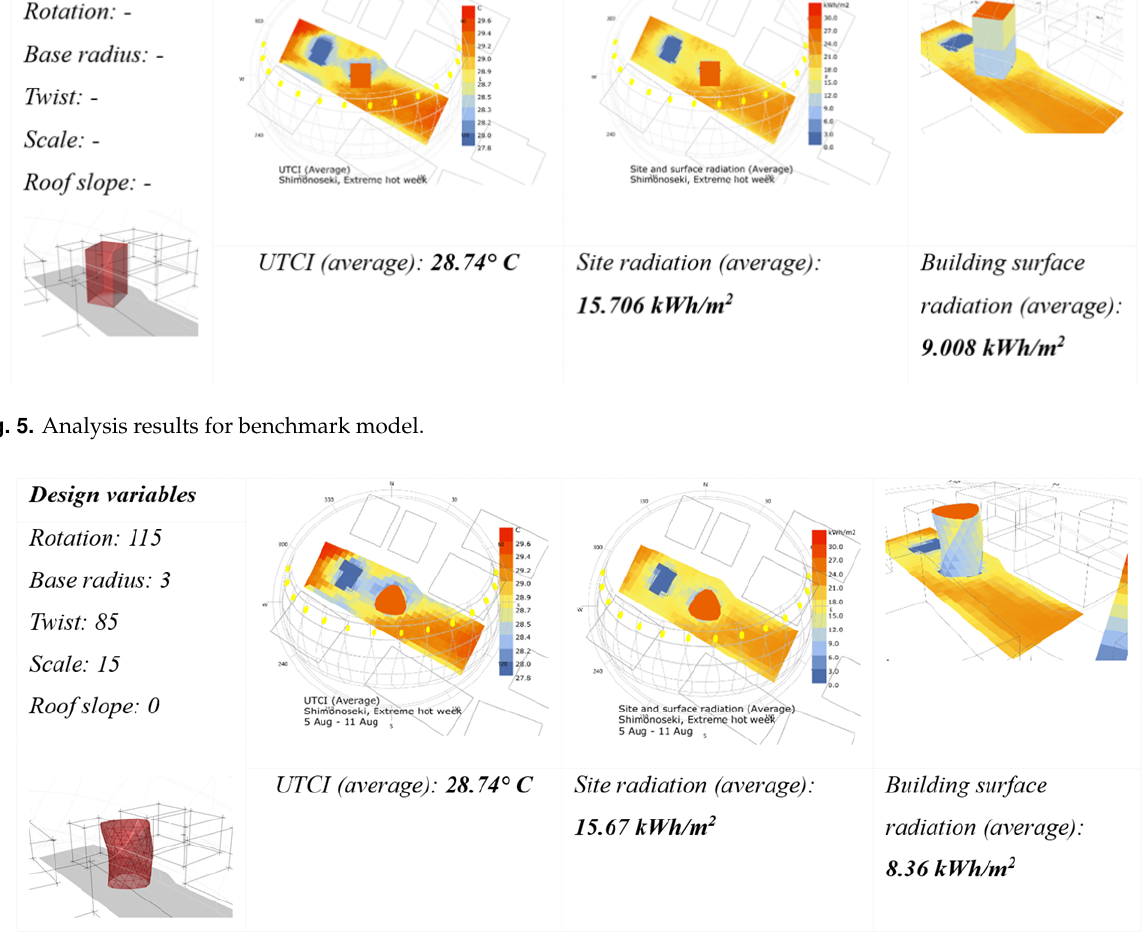
Fig. 6. Analysis results from minimum UTCI model.